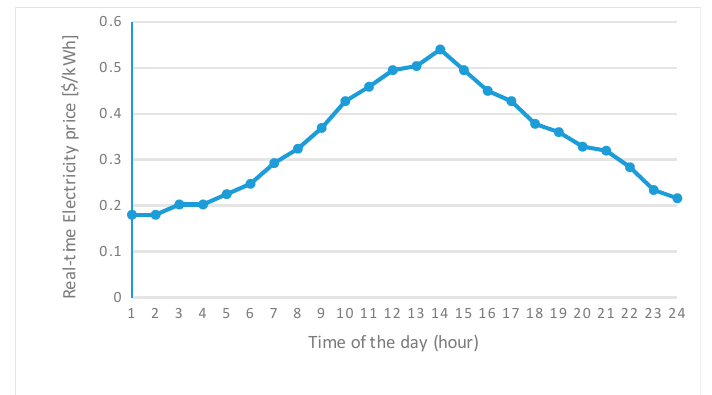
Figure 7. Load profiles of each microgrid. Table 4. Parameter setting of each microgrid. Parameter (Unit)